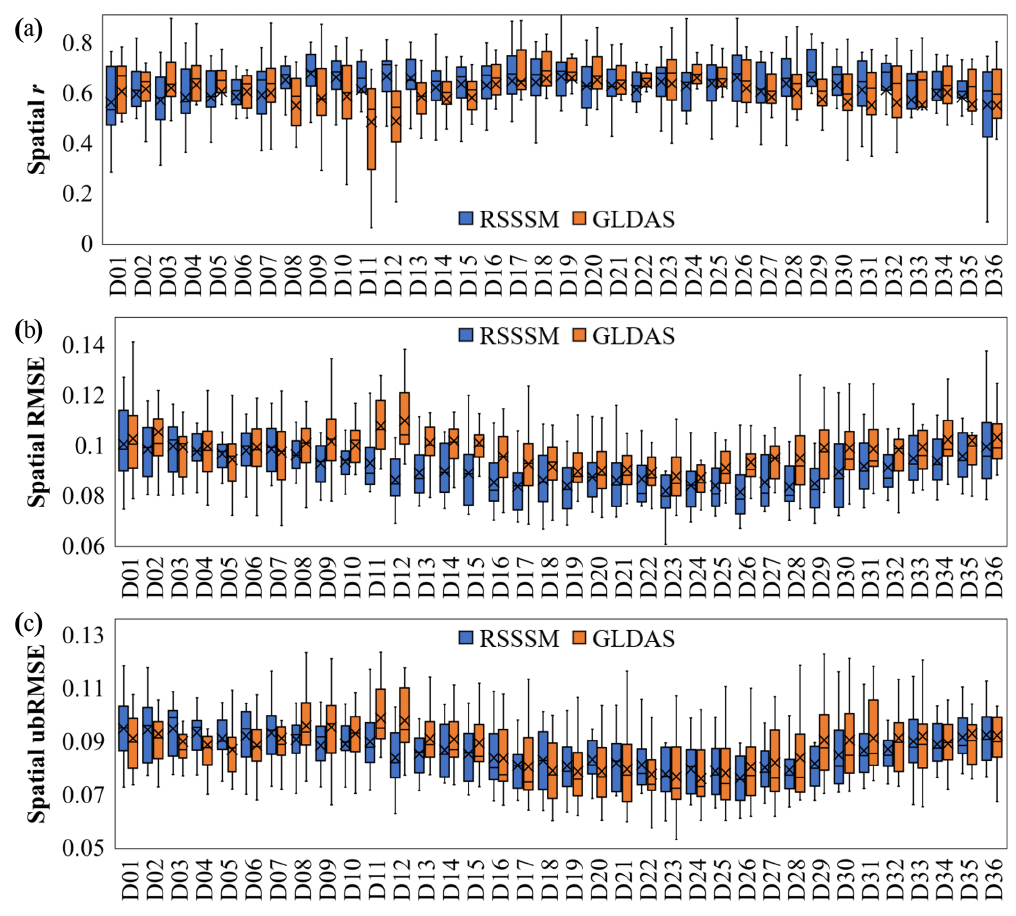
Figure 12. Comparison of the spatial accuracy between RSSSM and GLDAS during different 10d periods. The evaluation indexes are the same as those in Fig.